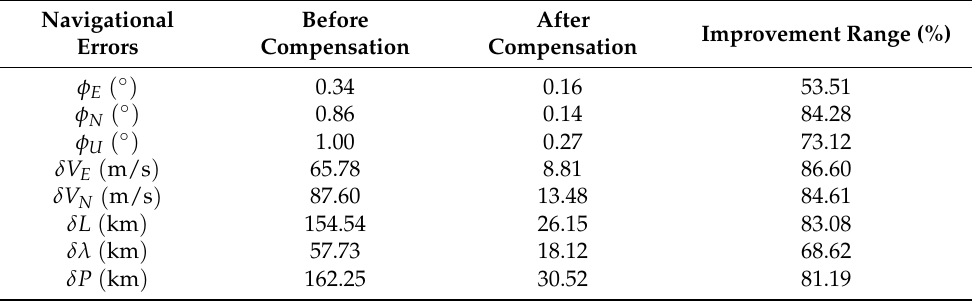
Table 6. Experimental results of attitude angle error, velocity error, and position